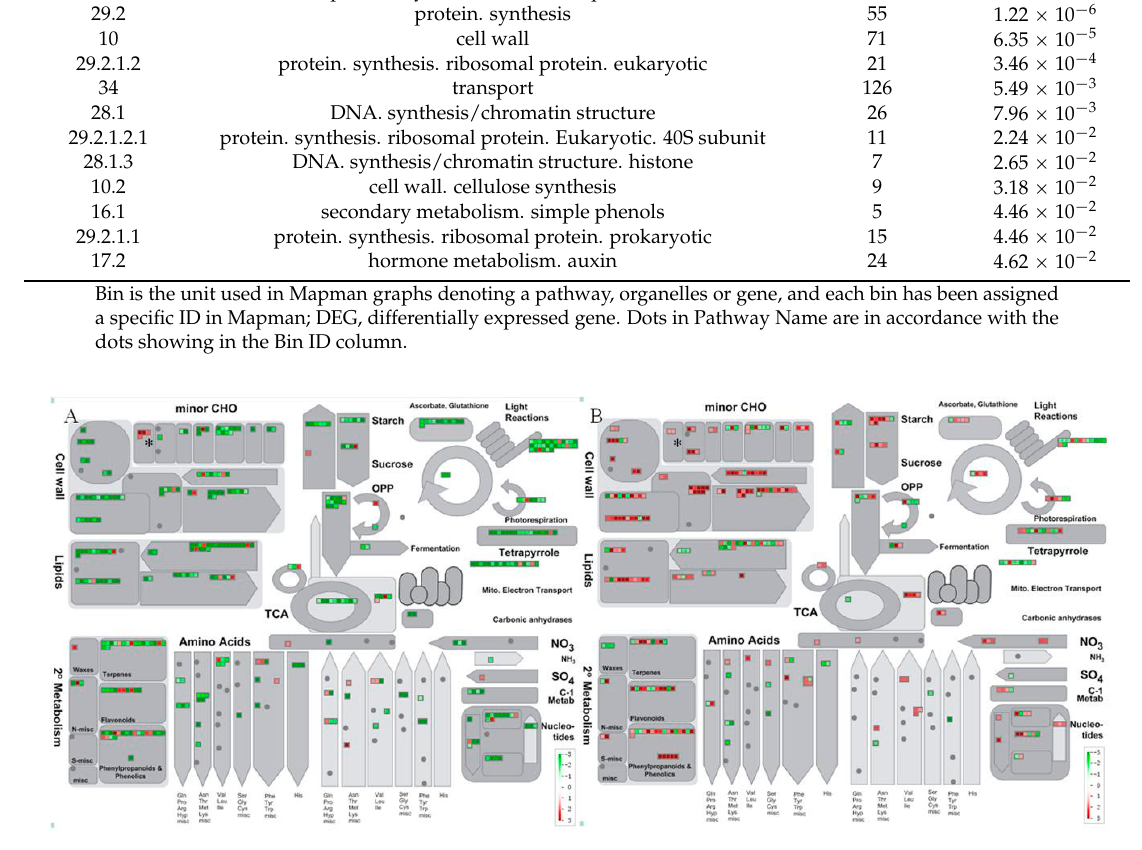
Figure 2. Overview of the DEGs involved in metabolisms at 13 ( A ) and 26 wpi ( B ) respectively in ponkan leaves infected with Asian citrus psyllid (ACP)-vectored C Las bacteria. The red show the genes that were significantly upregulated while the green show the significantly downregulated. CHO: Carbohydrate; TCA: Tricarboxylic acid cycle; OPP: Oxidative Pentose Phosphate; * Raffinose family metabolism; Grey dots: genes without significant expression difference, arrows were used to indicate the direction of the pathways.